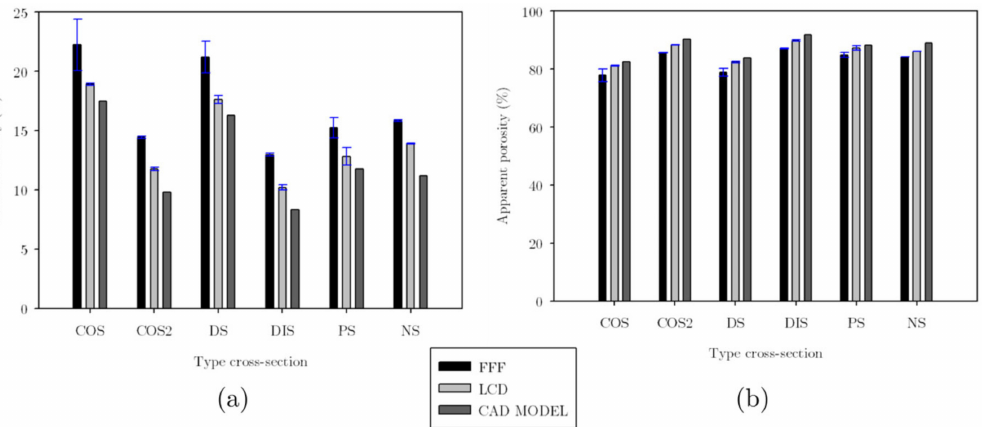
Figure 9. Comparison of the actual relative density ( a ) and the apparent porosity ( b ) of the additively manufactured samples and the computational models for UPLS.